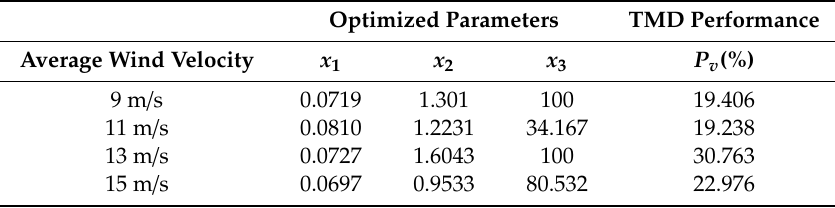
Table 5. Optimized parameters and TMD performance for various wind